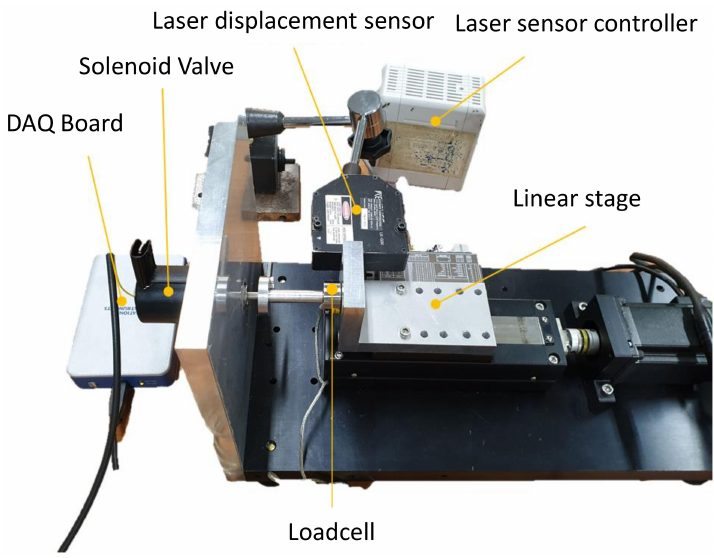
Figure 7. Experimental setup for measuring the attraction force with varying air